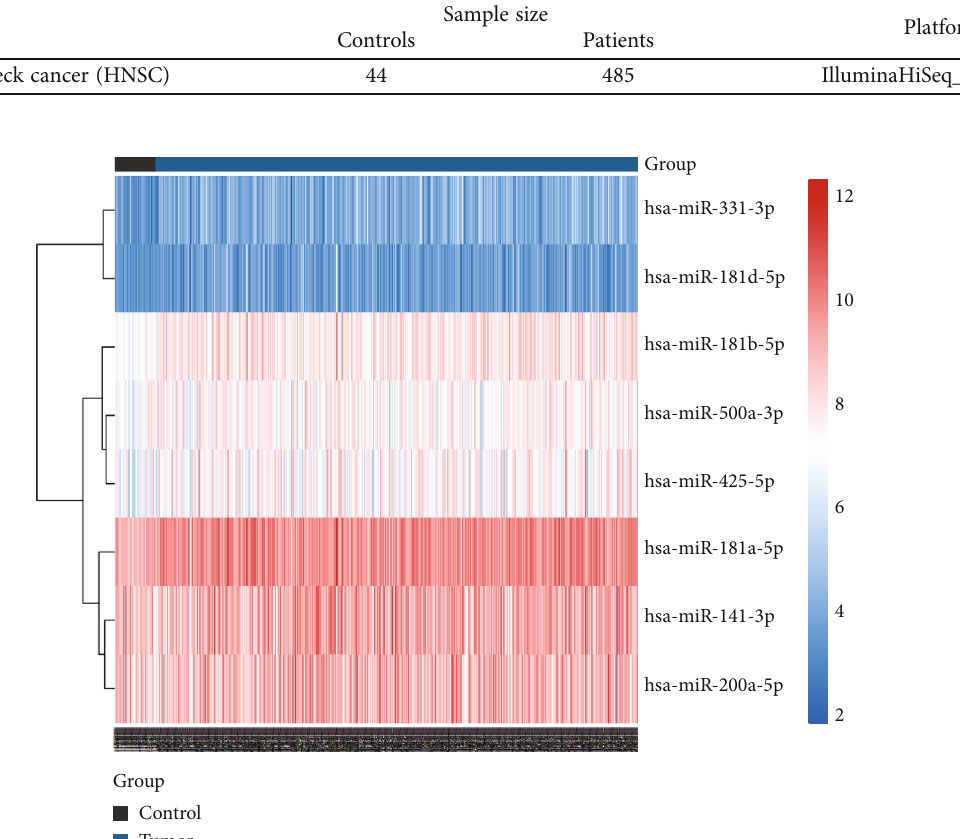
Figure 1: Heatmap of eight di ff erently expressed miRNAs between head and neck cancer and normal tissues. Red and blue represent up- and downregulated expression in tumor,